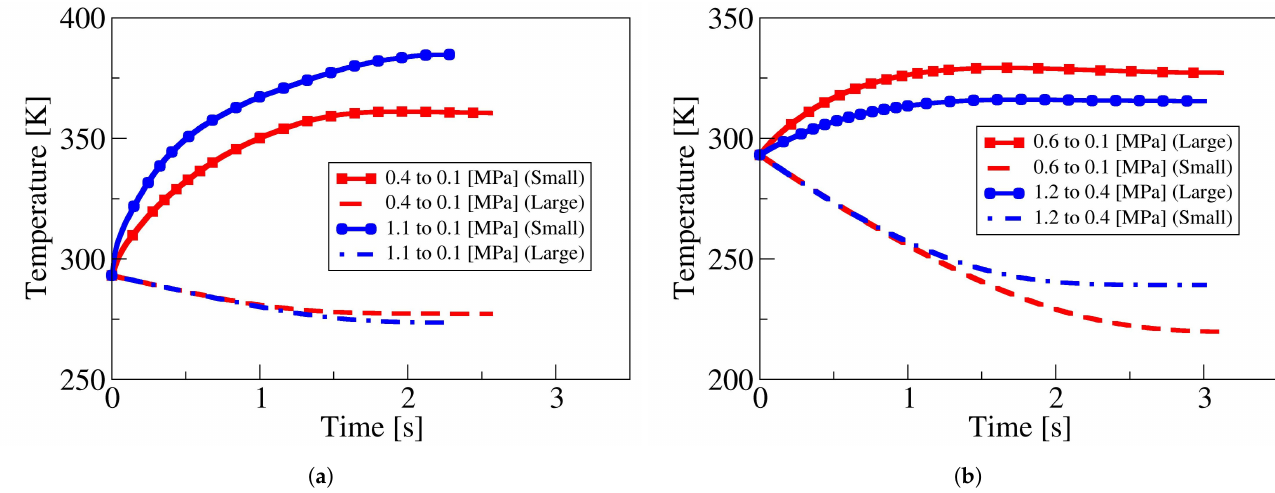
Figure 5. Numerical temperature evolution in the upstream and downstream reservoirs. ( a ) The flow goes from the large to the small reservoir. ( b ) The flow goes from the small to the large